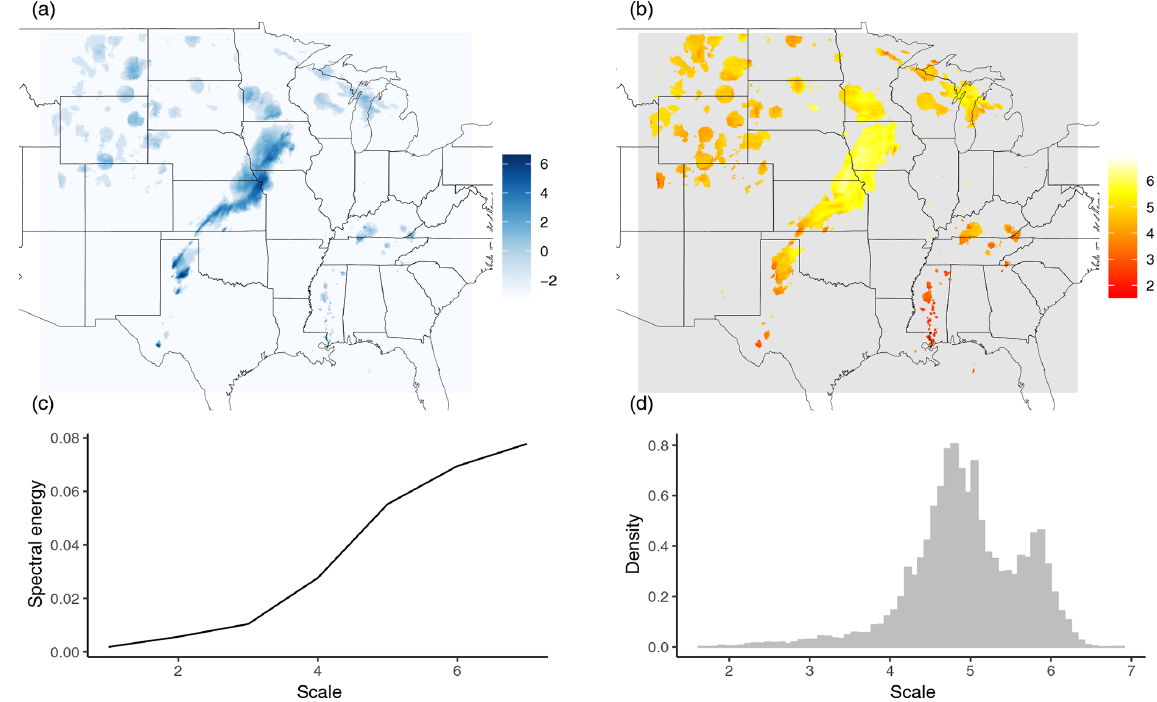
Figure 3. Logarithmic rain field (a) and corresponding map of central scales (b) from the stage II reanalysis on 13 May 2005. The field has been cut and padded with zeroes to 512 × 512, scales were calculated using the least asymmetric D 4 wavelet, only locations with non-zero rain are shown. Panels (c) and (d) show the corresponding mean spectrum and scale histogram,